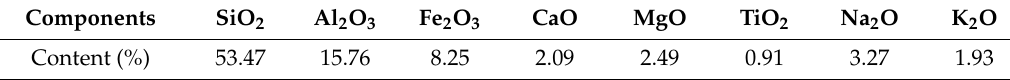
Table 1. Chemical and physical properties of seabed